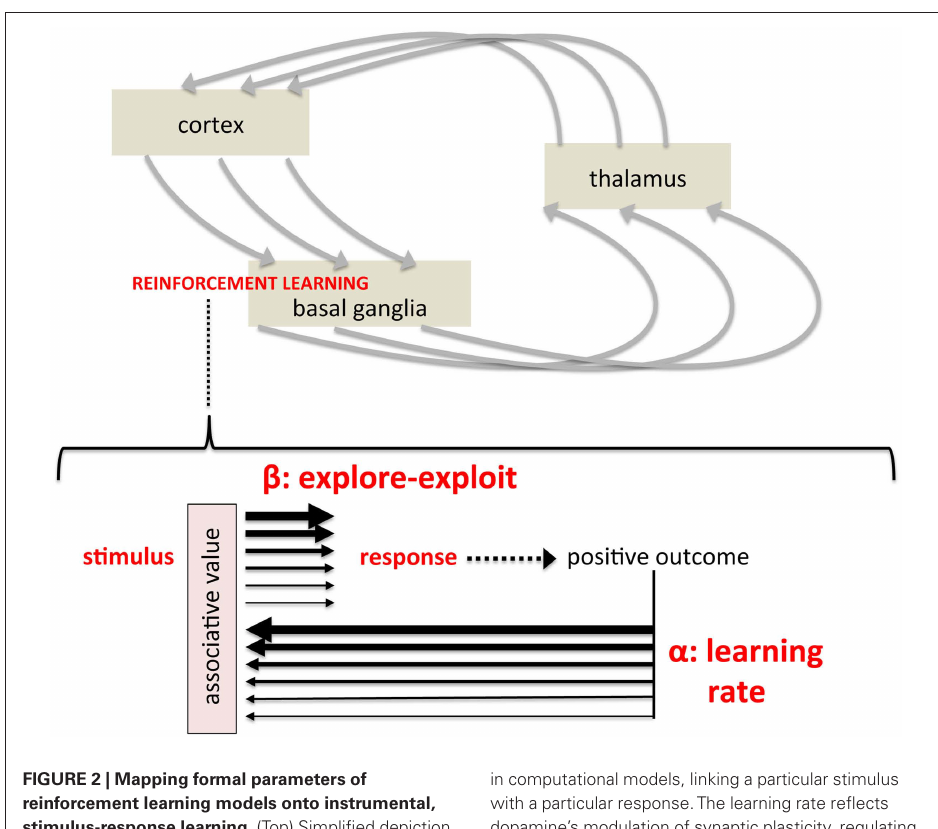
Figure 2 | Mapping formal parameters of reinforcement learning models onto instrumental, stimulus-response learning. (Top) Simplified depiction of cortico-basal ganglia-thalamo-cortical circuits believed to modulate cortical activity and action selection, representing a pathway by which striatum-based reinforcement learning influences behavior. (Bottom) A schematic showing the two key parameters of temporal difference models within a simple stimulus-response diagram. The light red box labeled “associative value” represents the synaptic strength, construed as “value”